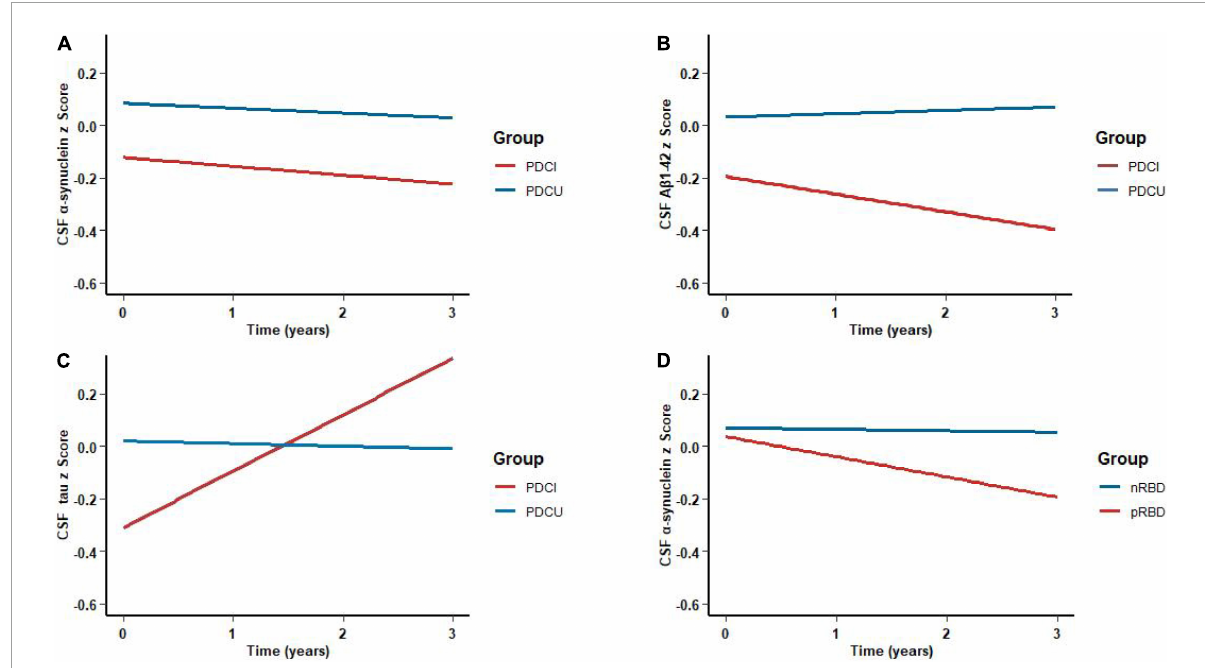
FIGURE3 Associations of cognitive impairments with lower cerebrospinal fluid (CSF) biomarker levels during the follow-up. Temporal trajectories of CSF (A) α -synuclein (B) and A β 1 − 42 show a decline in cognitive impairments. However, CSF (C) t-tau was elevated. Longitudinal associations of sleep disorders with CSF (D) α -synuclein were shown. * P < 0.05.